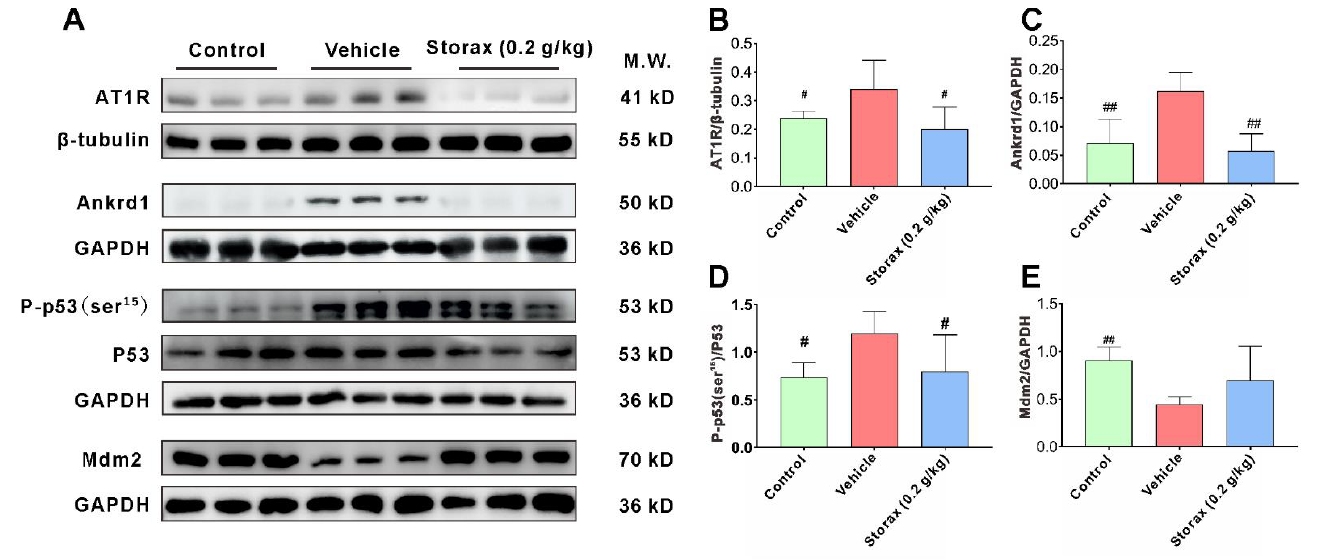
Figure 8. Storax inhibits the AT1R–Ankrd1–P53 pathway in AMI rats against cardiomyocyte apoptosis. ( A ) WB bands showing the protein expression levels of AT1R, Ankrd1, P-p53 (ser15), P53 and Mdm2 in cardiac tissue. ( B – E ) Relative protein for AT1R, Ankrd1, P-p53 (ser15) and Mdm2 were quantified by densitometry based on immunoblot images. Results are presented as mean ± SD (n = 3). One-way ANOVA follow by Bonferroni’s post hoc test: # p < 0.05, ## p < 0.01 vs. vehicle group.